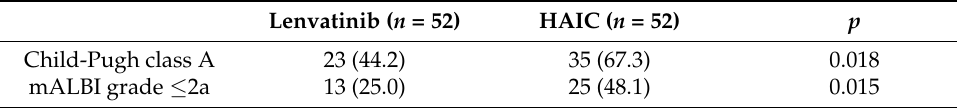
Table 5. Residual liver function at the time of best treatment